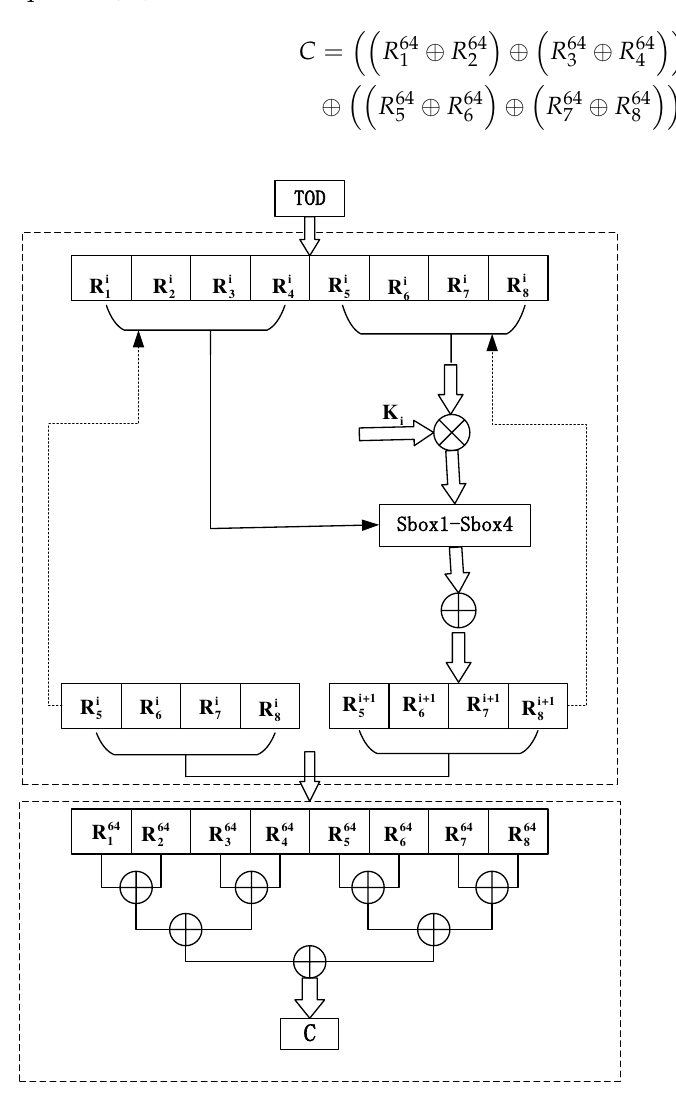
Figure 4. Flowchart for the GOST method-based secret key